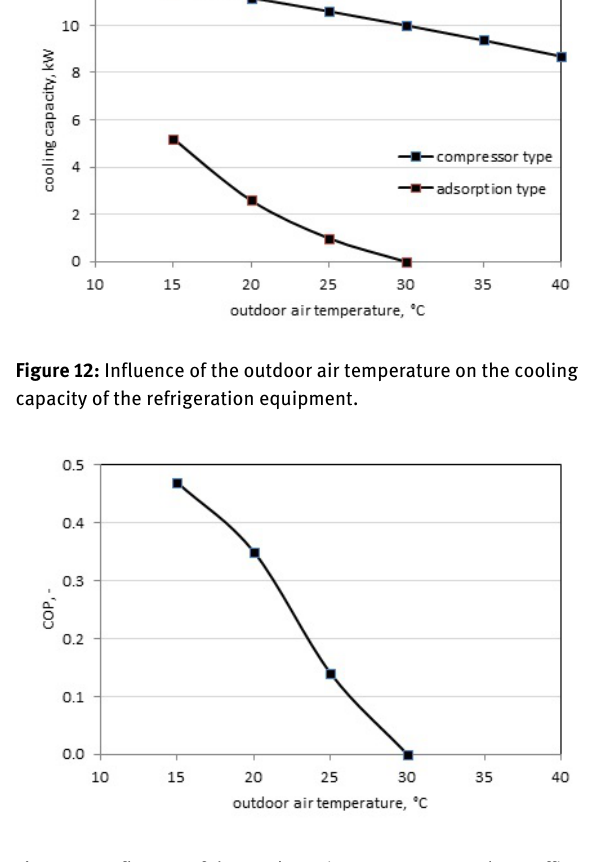
Figure 13: Influence of the outdoor air temperature on the coefl- cient of performance COP.